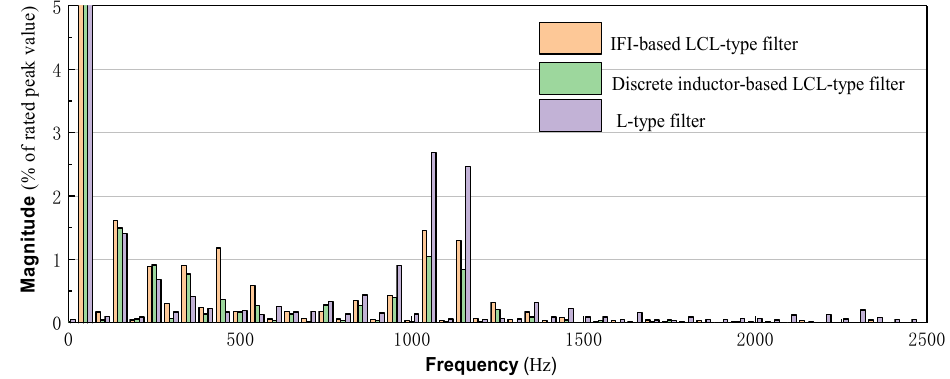
Figure 11. Comparison of simulated fast Fourier transform (FFT) analysis result of secondary-side current (i s 1 ).